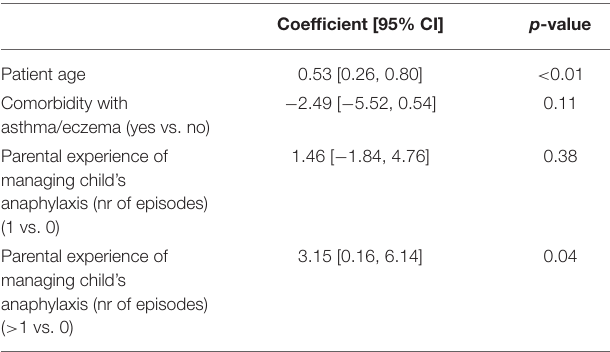
TABLE 2 | Linear regression on perceived knowledge total score with backward selection of variables based on